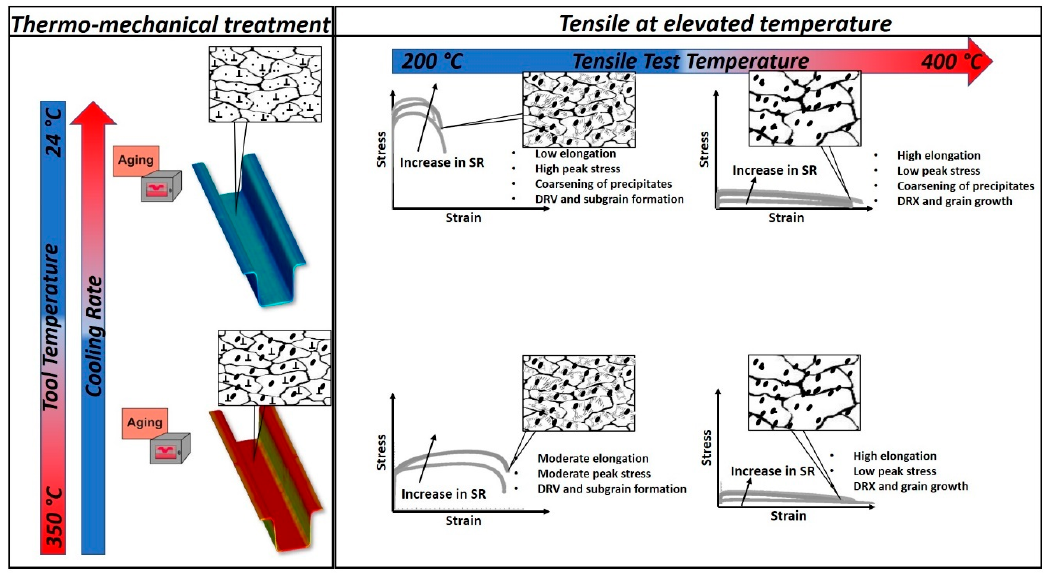
Figure 9. Schematic illustration highlighting the microstructural evolution induced by the thermomechanical process as well as tensile tests at elevated temperatures.